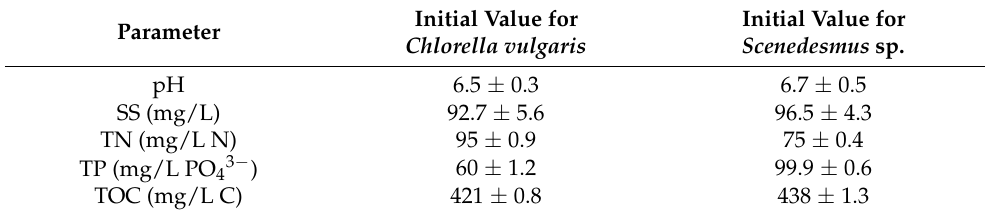
Initial Value for Scenedesmus sp.